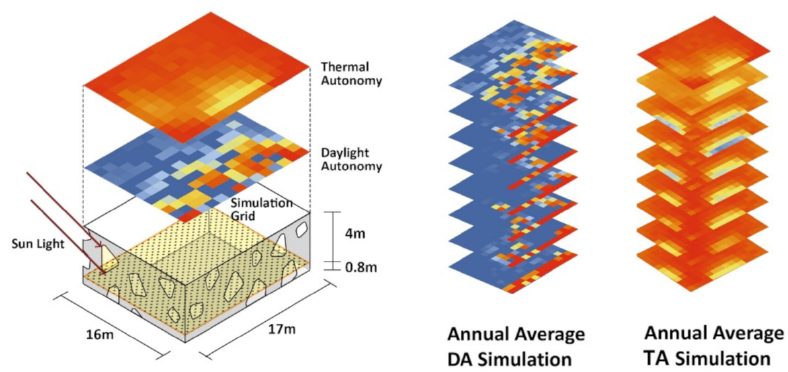
Figure 8. Simulation setting showing the façade, test points, sun rays, TA, and DA visualization.